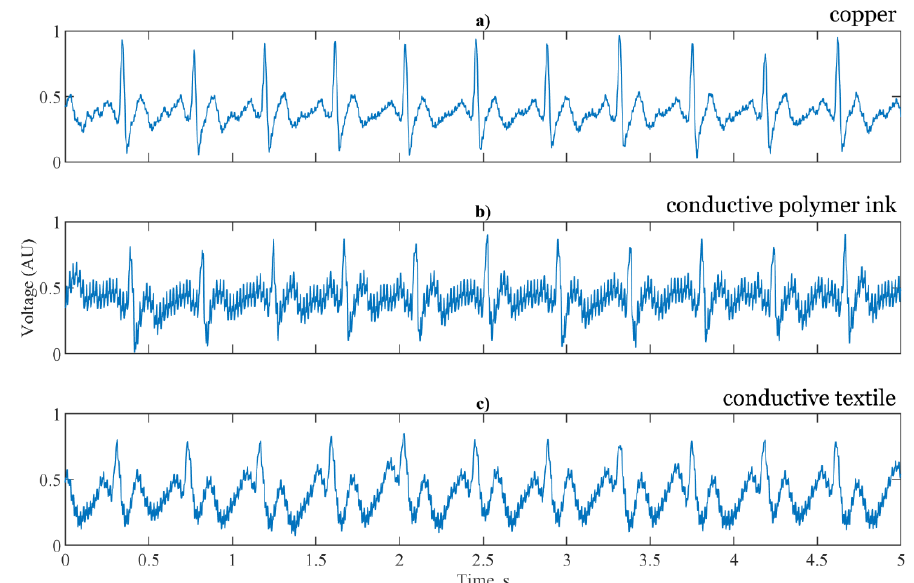
Figure 10. Photograph of prototype system hardware in neonate simulation environment: (a) front end and GUI (Dimensions 195 × 100 × 90mm); (b) USB 5V power bank; (c) EPS sensors and textile based electrodes; (d) digital to analogue converter for test signal generation; (e) neonate manne- quin with internal antenna; (f) commercial delivery room mattress.